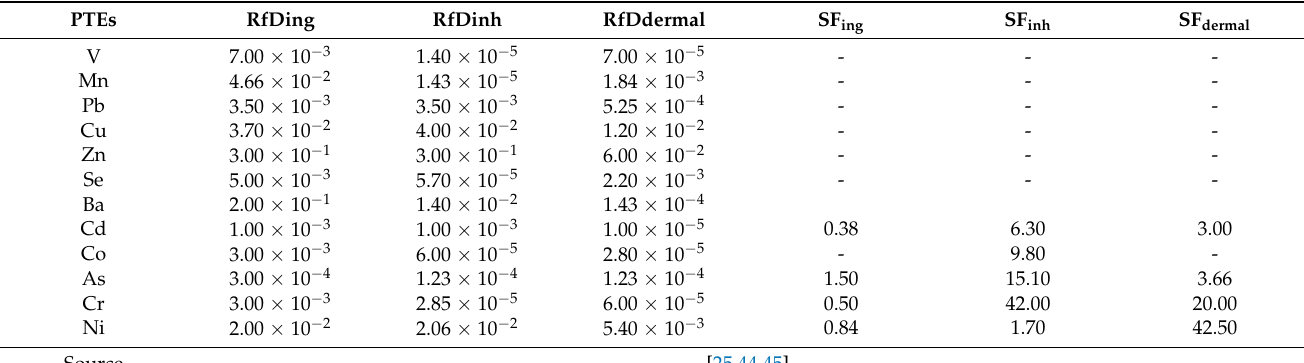
Table 4. RfD and SF value of different elements for different exposure